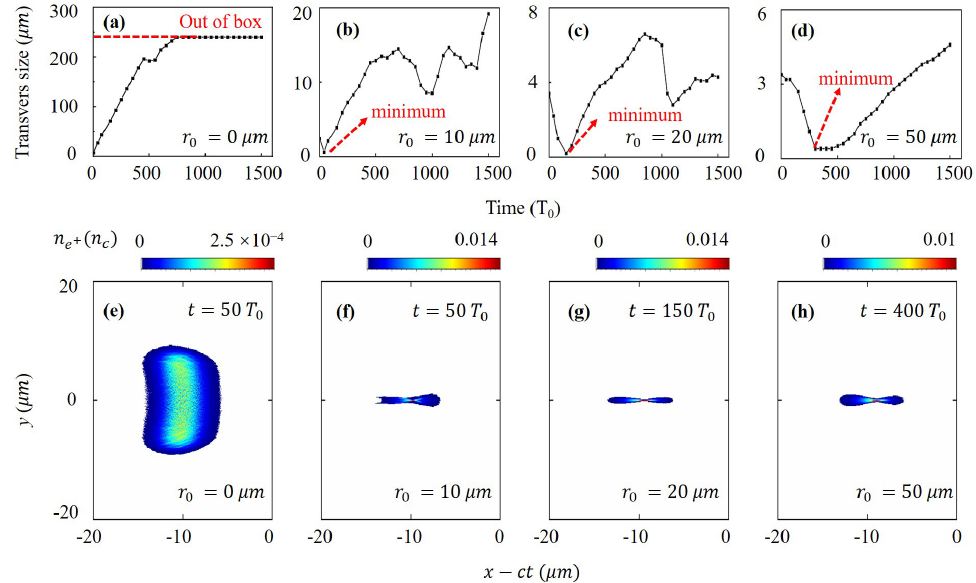
Figure 6. Time variations of the transverse positron beam size at different drive beam radii, i.e., r 0 = 0 µ m ( a ), 10 µ m ( b ), 20 µ m ( c ) and 50 µ m ( d ). Positron density distribution in the x-y plane ( e – h ) at the moment of minimum transverse size, as marked in ( a – d